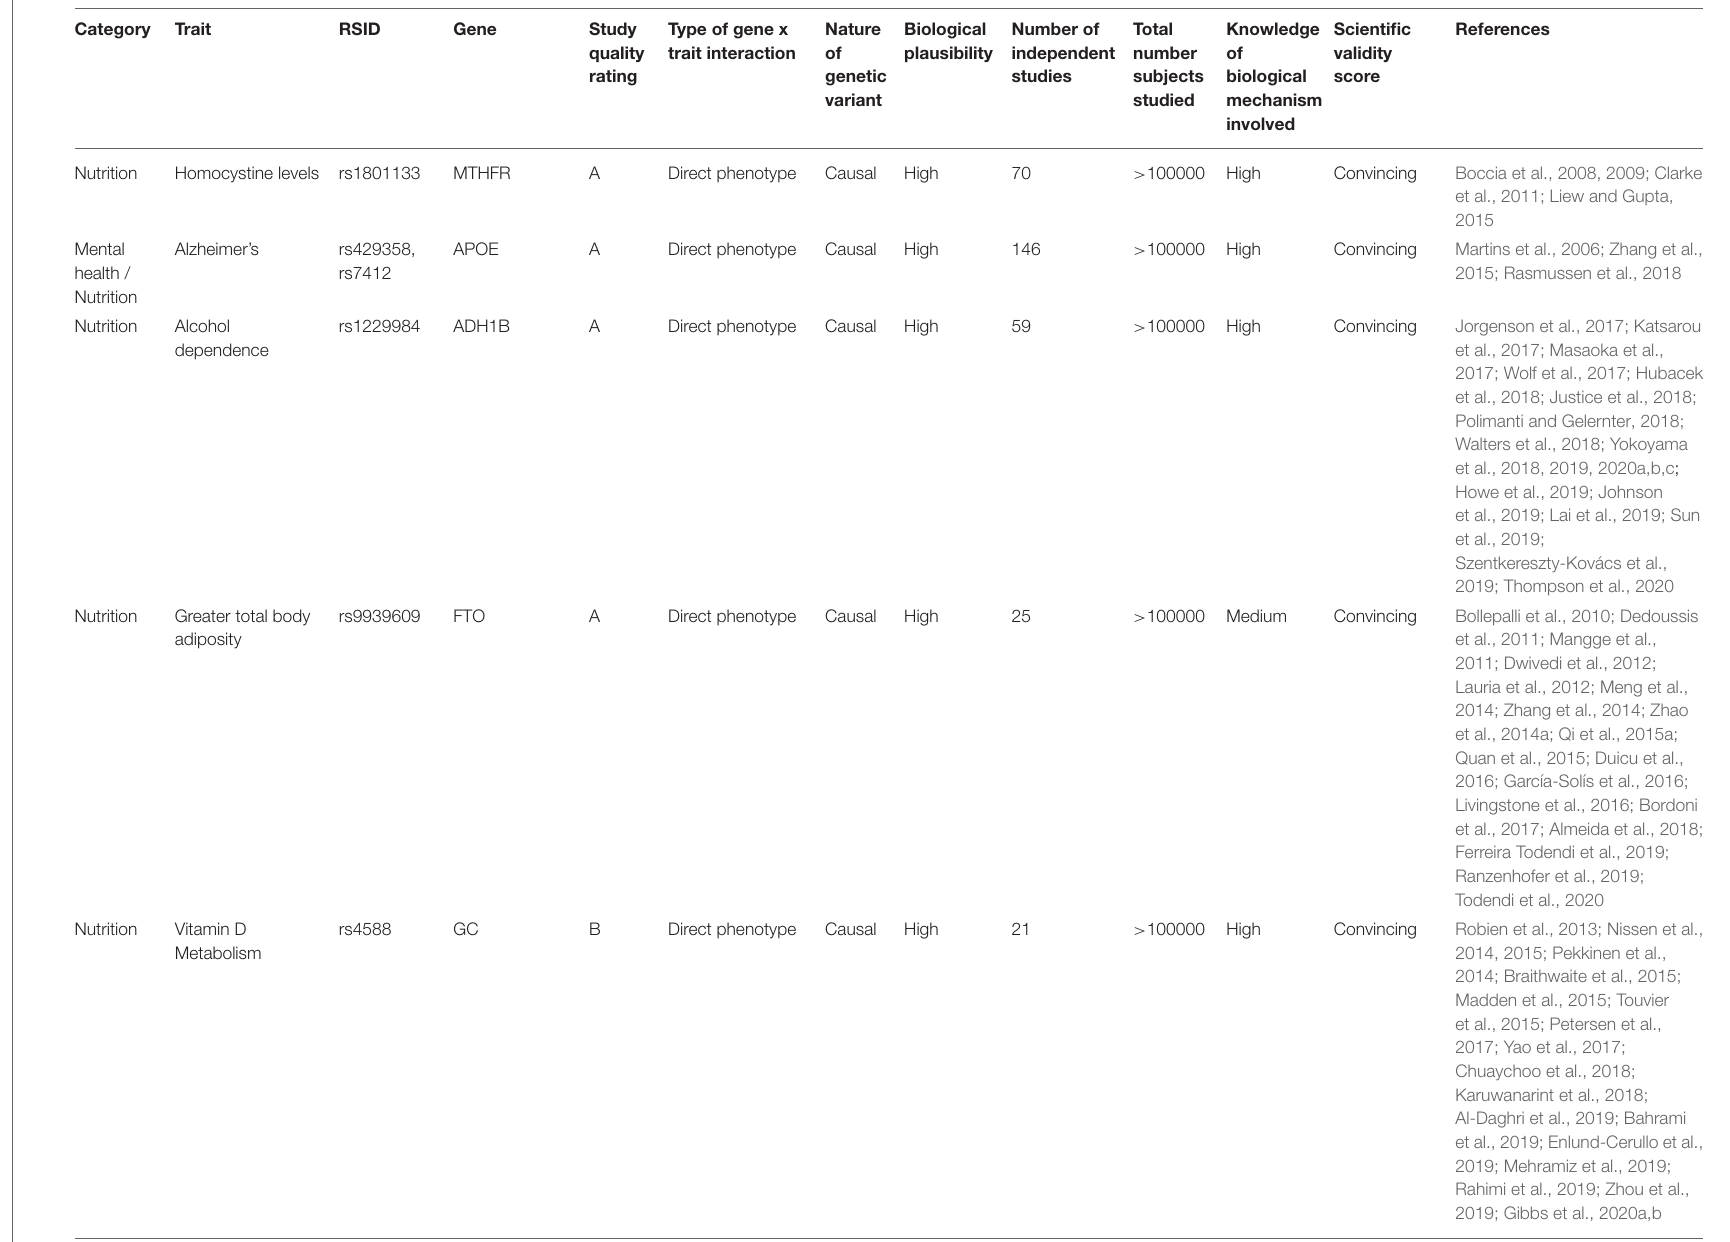
TABLE 4 | Summary of nutrition trait analysis candidates assessed according to the scientific validity score as proposed by Grimaldi et al. (2017). Category